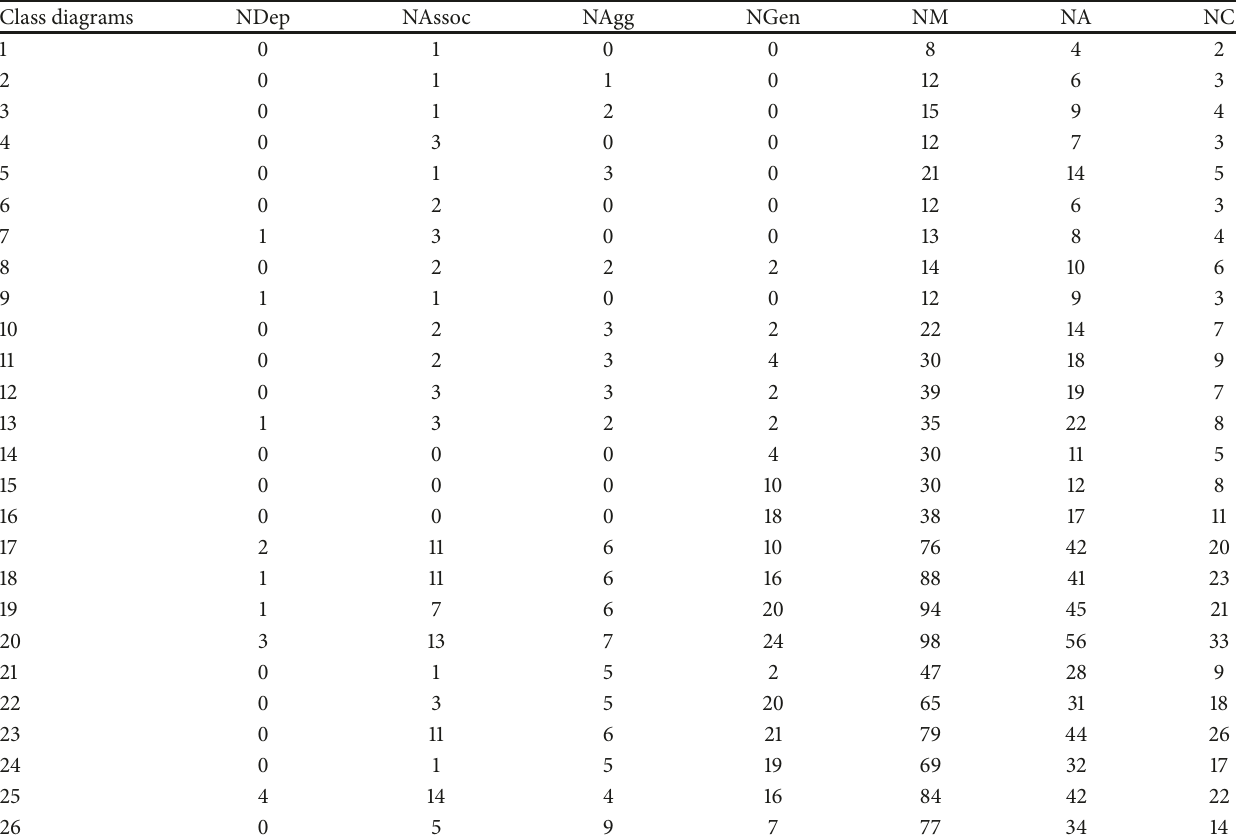
Table 1: Twenty-six UML class diagrams evaluation indicators.